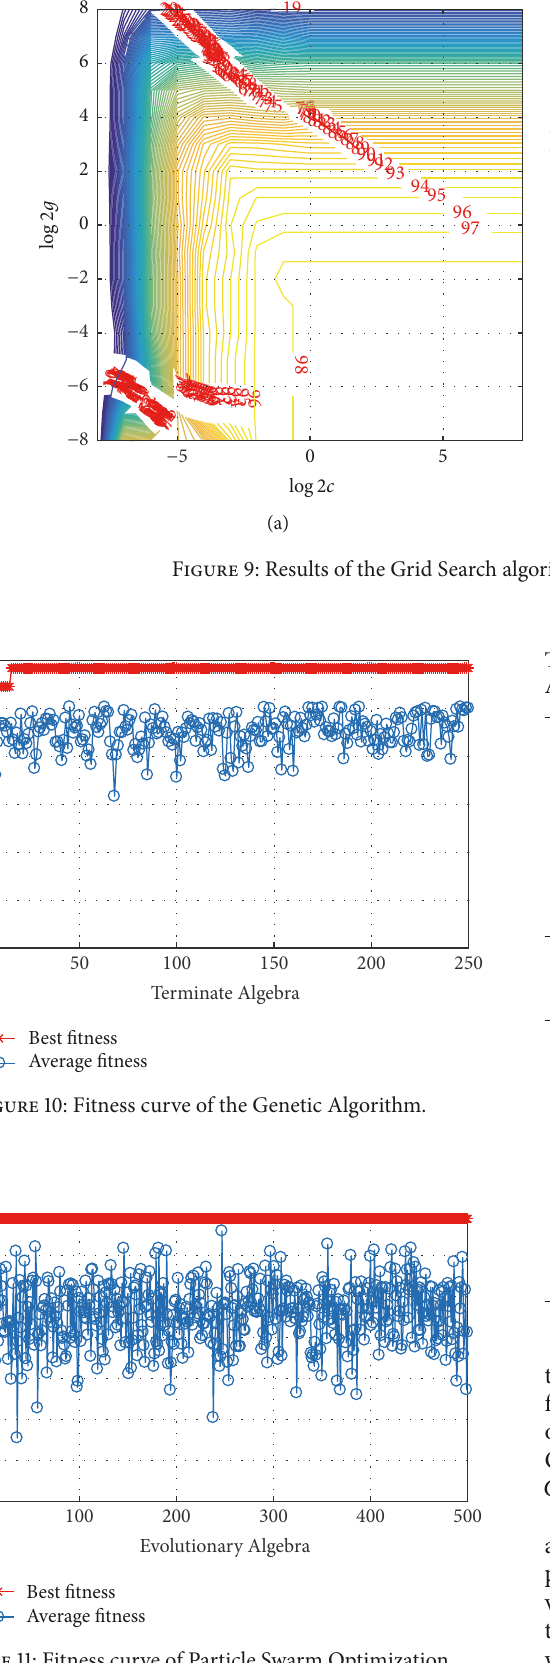
Figure 11: Fitness curve of Particle Swarm Optimization.